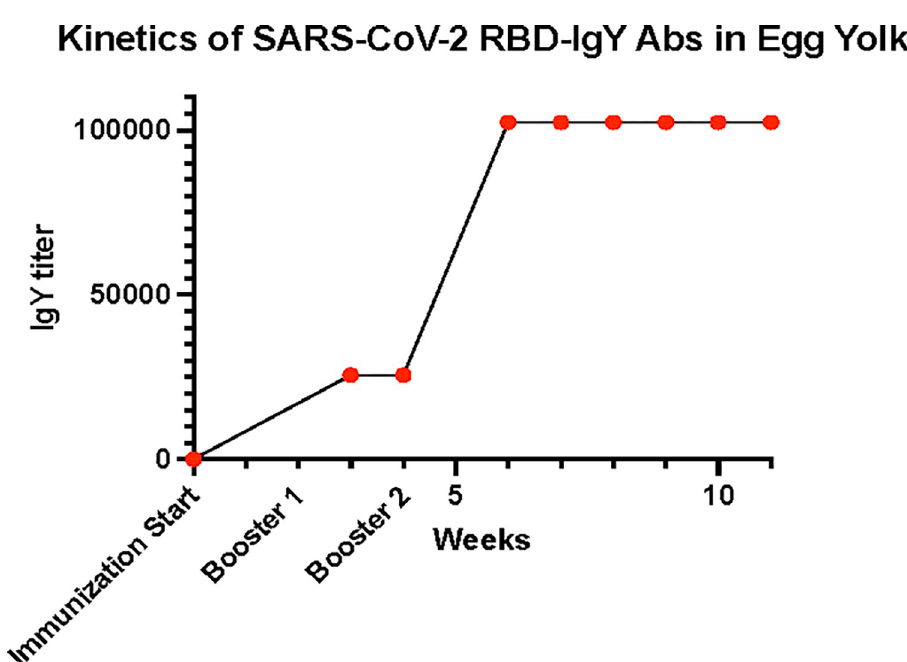
Fig 2. Egg yolk anti-SARS-CoV-2 RBD IgY antibodies were measured after immunization.